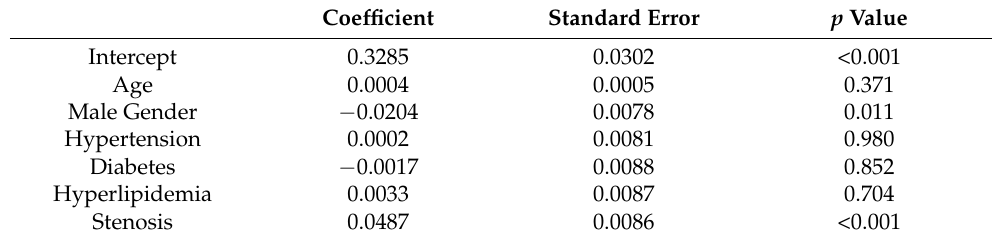
Table 5. Relations between the maximum First Harmonic Ratio and multiple factors (N = 76).